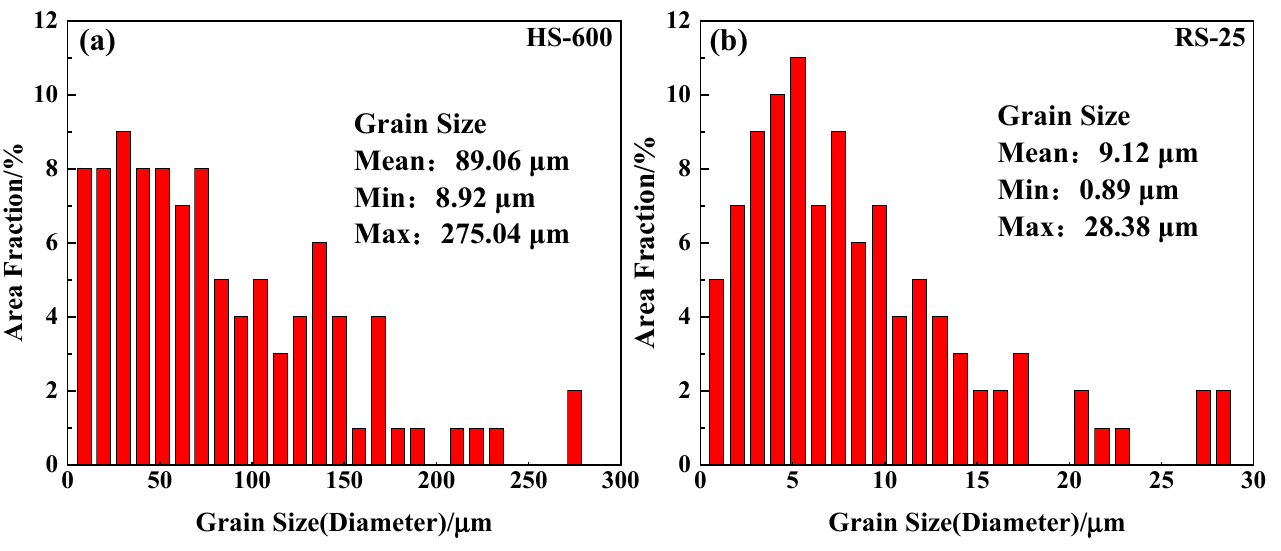
Figure 4. The statistics data of grain size: for ( a ) HS-600 and ( b ) RS-25, respectively. Based on the recrystallized fraction component of HKL Channel 5 software [17], the grains were classified into three types (Figure 5a,b): recrystallized (blue), substructured (yellow), and deformed (red). It is helpful to further clarify the microstructure characteristics of the high-purity Ag samples under severe plastic deformation. Based on the statistics data (Figure 5f), the volume fractions of recrystallized and substructured grains for the HS-600 sample are 45.6% and 53.2%, respectively. The dominant microstructure of the RS-25 sample is substructured (74.3%) and deformed (22.5%). The results can be correlated to the dynamic deformation process and the subsequent static (cooling, storage) process.